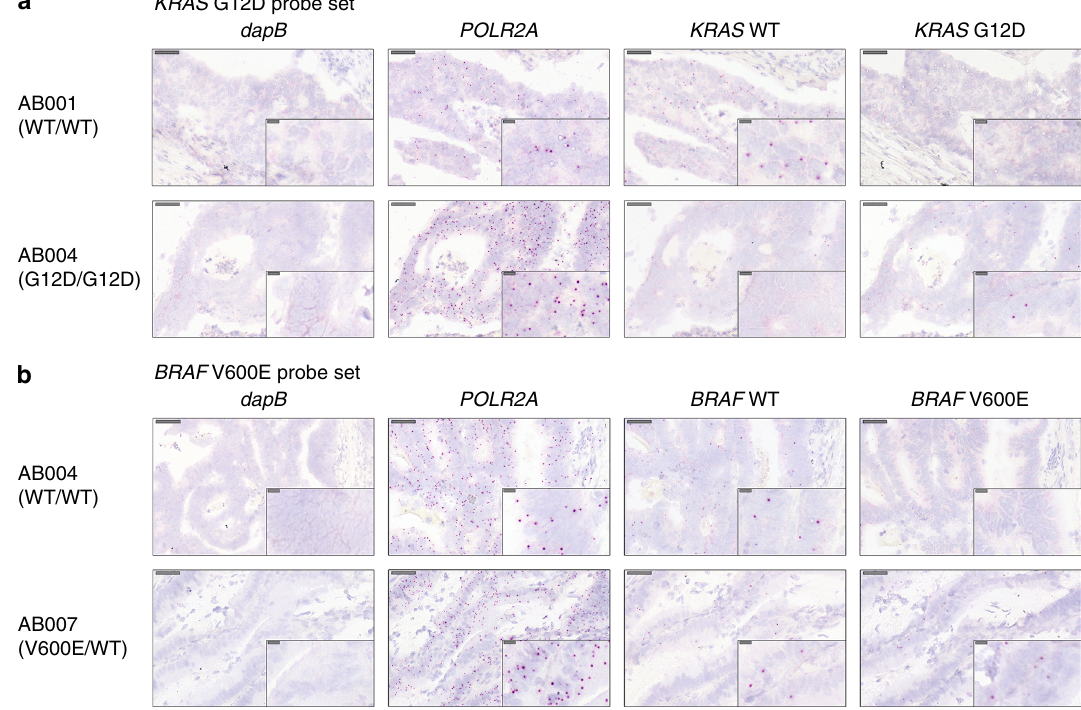
Fig. 2 Validation of BaseScope probes in tumors. Representative images of the validation of the KRAS G12D probeset a and BRAF V600E probeset b in archival human tumor tissue. In both cases a wild-type tumor and a mutant tumor are shown, with a negative control probe ( dapB ), a positive control probe ( POLR2A ), the wild-type probe and the mutant probe. Scale bars represent 50 micron and 10 micron